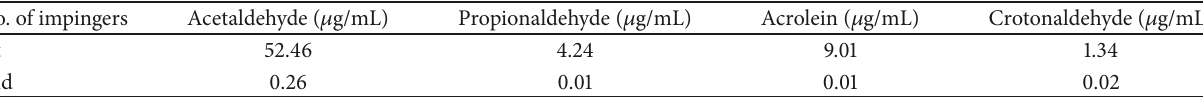
Table 2: The trapping effect of two impingers.